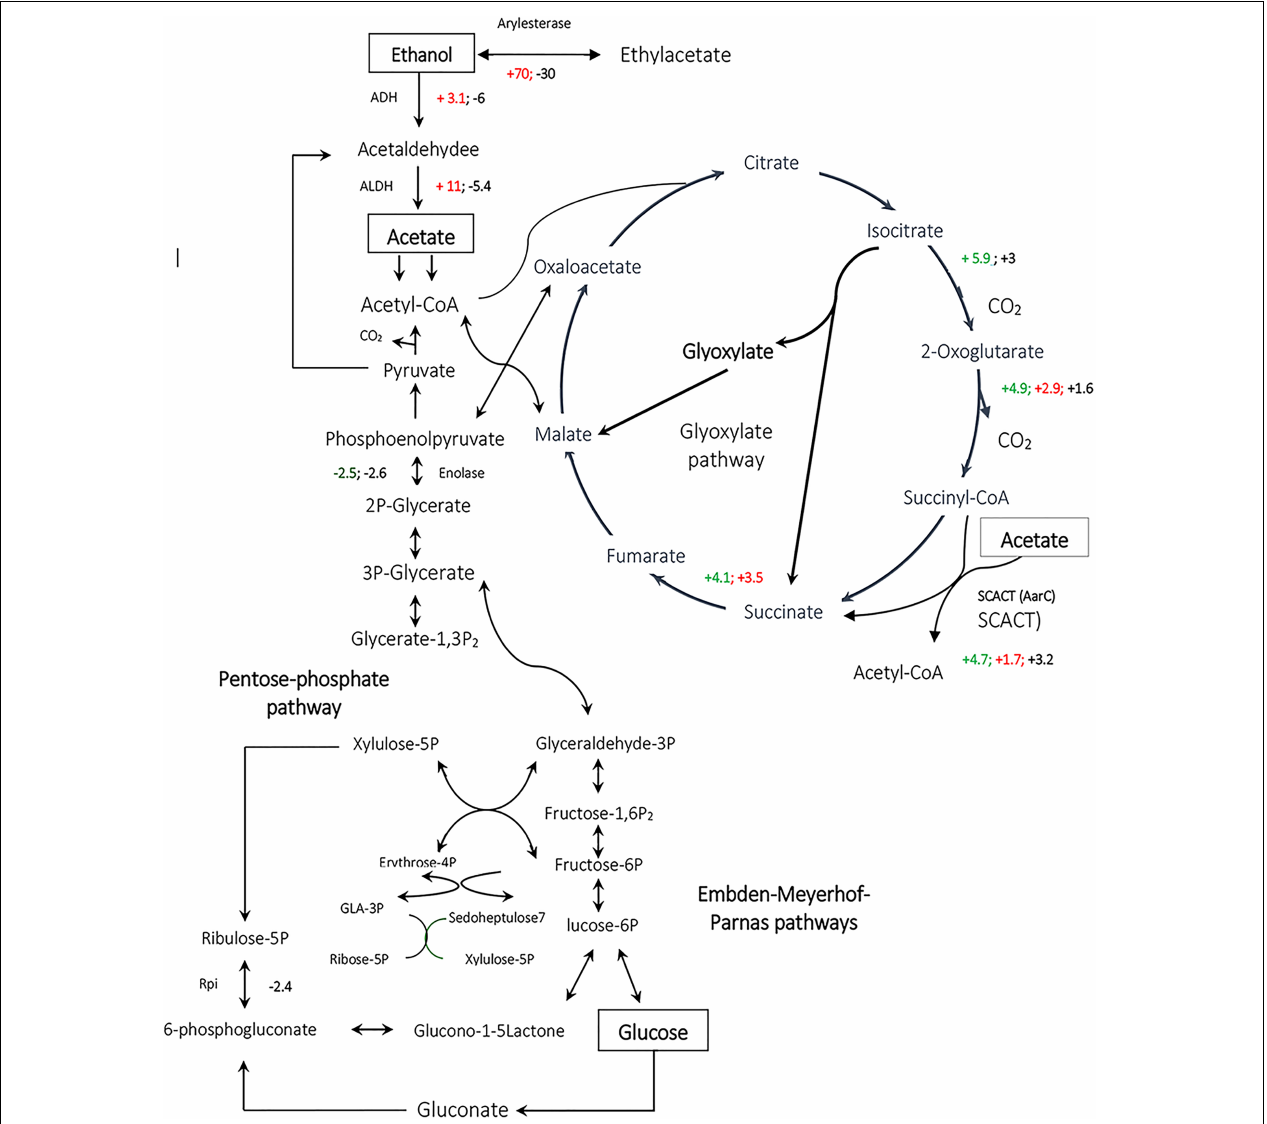
FIGURE 6 | Comparative analysis of the expression of enzymes involved in metabolic pathways for Acetobacter spp. Acetobacter senegalensis LMG 23690 T was able to consume a mixture of glucose and ethanol (condition EtOH), glucose (condition Glc) or a mixture of glucose and acetic acid (condition GlcAA) at 30 ◦ C and pH 3.9. By comparison of each condition with two other conditions, we could determine the significant up-regulated or down-regulated proteins. The up-regulated proteins in ethanol condition have been shown as red positive numbers whereas the up-regulated proteins in Glc conditions have been shown as red negative numbers. GlcAA-Glc represents the comparison between GlcAA and Glc conditions. The up-regulated proteins in GlcAA condition have been shown as green positive numbers whereas the up-regulated proteins in Glc condition have been shown as green negative numbers. GlcAA-EtOH represents the comparison between GlcAA and EtOH conditions. The up-regulated proteins in Glc AA condition have been shown as black positive numbers whereas the up-regulated proteins in EtOH condition have been shown in black negative